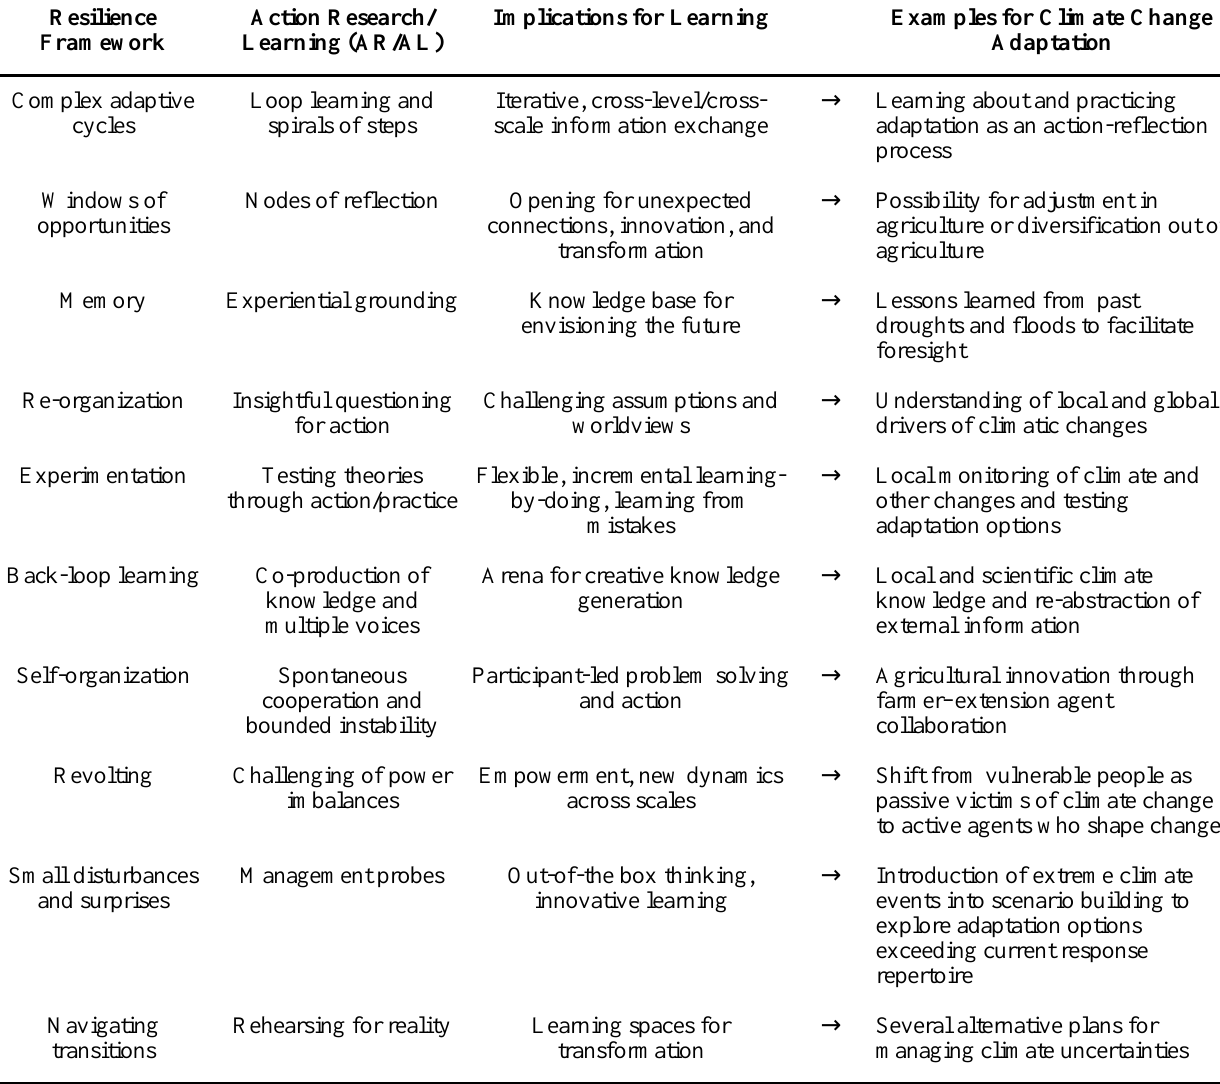
Table 1. Conceptual similarities and overlaps between the resilience framework and participatory action research/learning (AR/AL), implications for learning, and examples for climate change